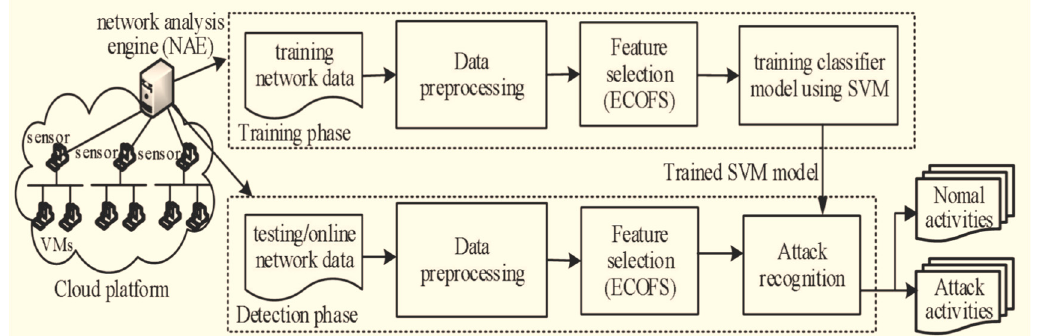
Figure 1 . Cloud platform for IDS [17] . Figure 1. Cloud platform for IDS